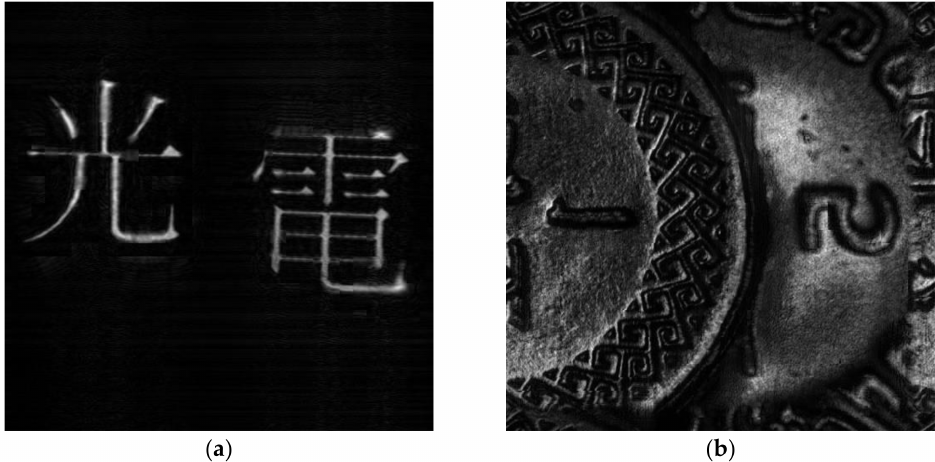
Figure 8. ( a ) EDF image of hologram “A” reconstructed with our proposed method ( M = 20) with filtering on the depth map; ( b ) EDF image of hologram “B” reconstructed with our proposed method ( M = 20) with filtering on the depth